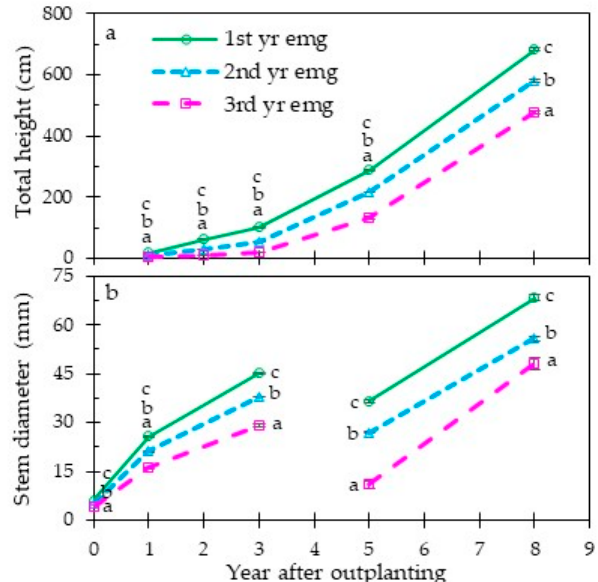
Figure 3. Seedling height ( a ) and stem diameter (breast height diameter for Years 5 and 8) ( b ) of longleaf pine seedlings that emerged from the grass stage during the first, second, or third year in the field. For each year, the same letter indicates no significant differences at the Bonferroni-adjusted 0.05 level. Error bars represent 1 SE.